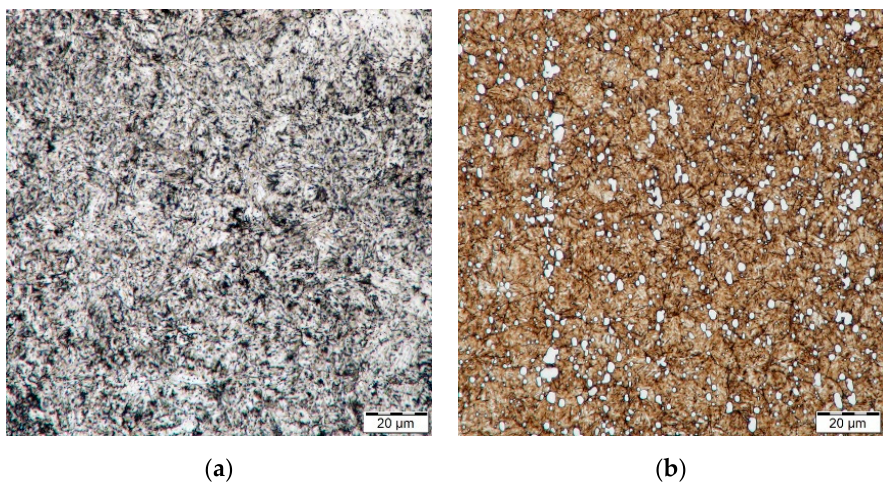
Figure 2. Microstructure of steel ( a ) H13; ( b ) HS6-5-2 with magnification 1000×.